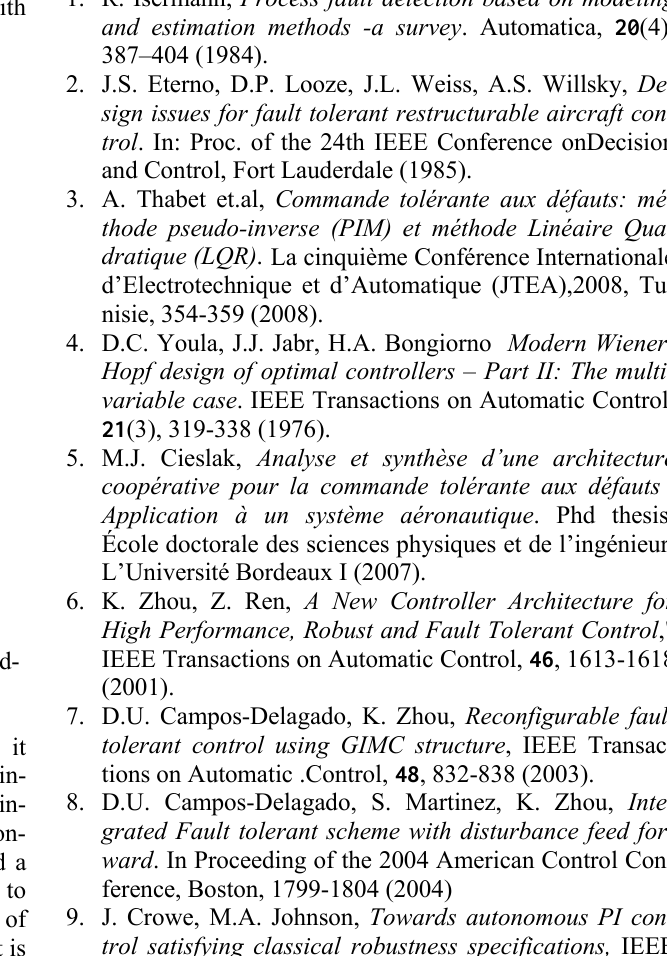
Fig.15. Frequency variation F